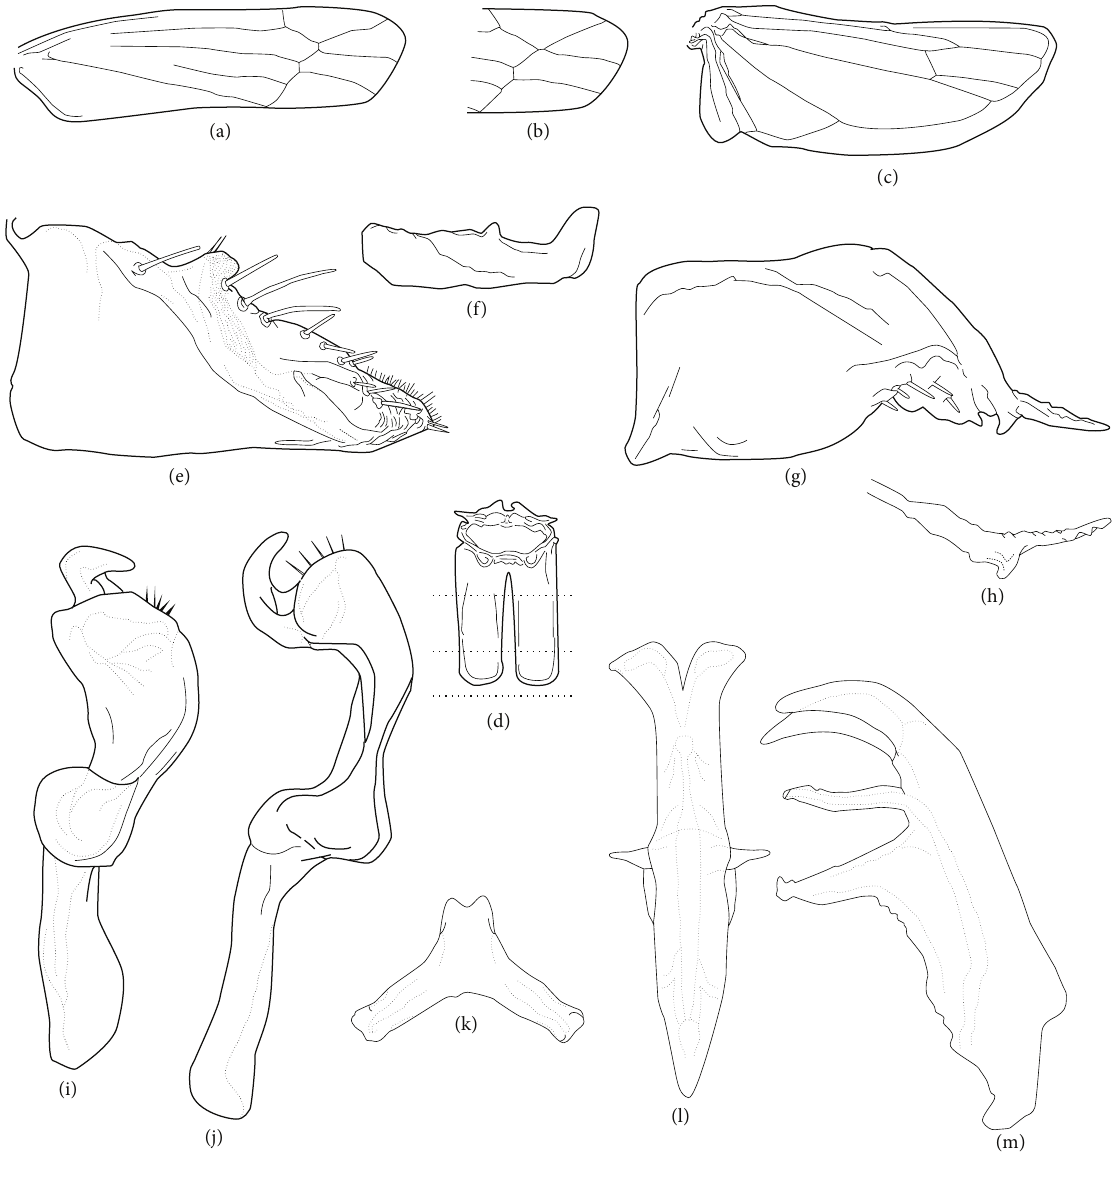
Figure2: Dikrellacaryocar n.sp.,male:(a)forewing;(b)forewingshowingavariationinbaseofthirdapicalcell;(c)hindwing;(d)abdominal apodeme; (e) subgenital plate (ventrolateral); (f) subgenital plate (lateral); (g) pygofer (lateral); (h) process of pygofer (dorsoposterior); (i) style (ventral); (j) style (lateral); (k) connective (ventral); (l) aedeagus (ventroposterior); and (m) aedeagus